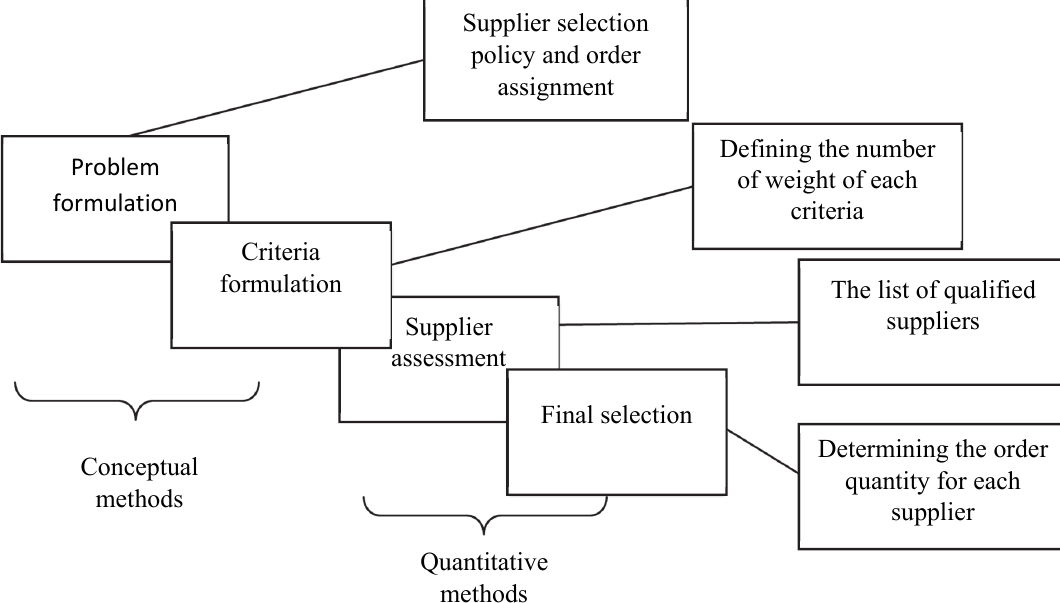
Fig. 1. The general framework for supplier selection and order